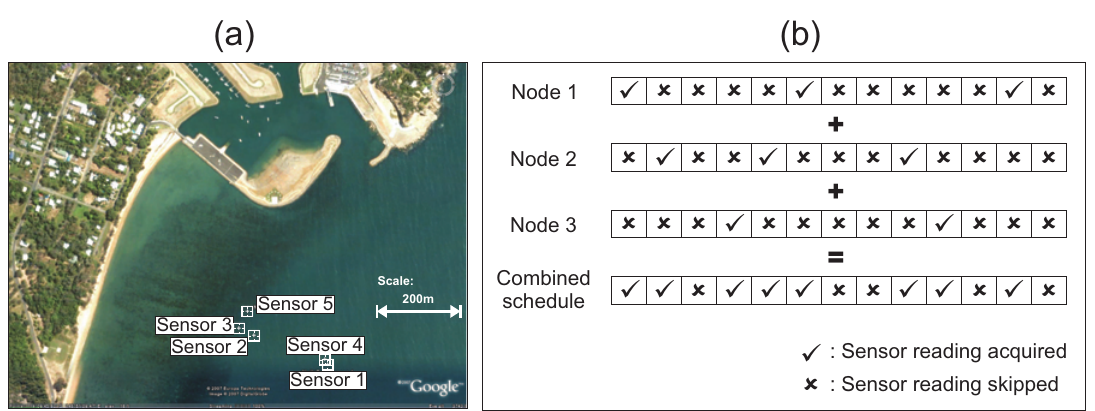
Figure 5. (a) Sensors deployed in Nelly Bay, Great Barrier Reef, Australia; (b) Combining schedules of adjacent nodes helps improve temporal coverage.